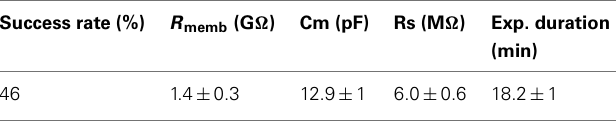
Table 3 | Success rate, cell parameters, and experiment duration for n = 69 iCell